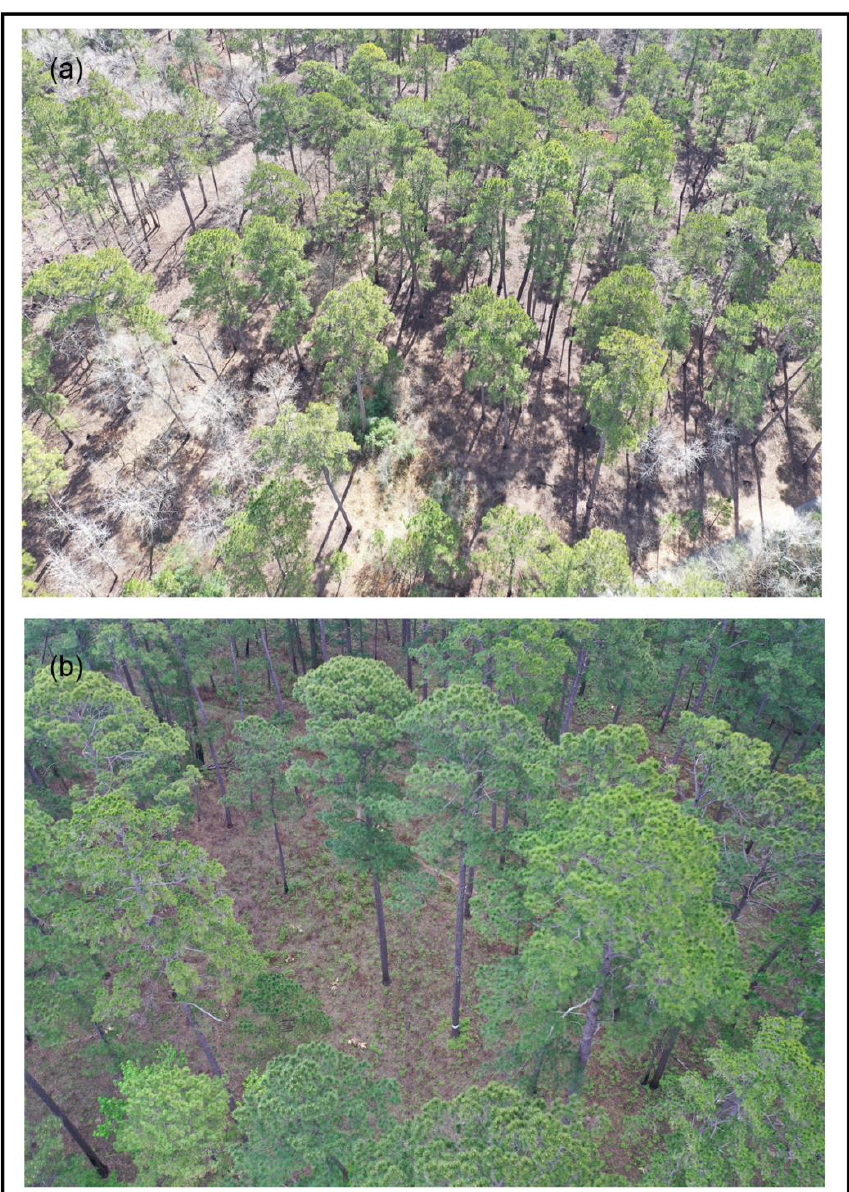
Figure 2. Differences between training sample images collected at altitudes of ( a ) 76 m and ( b ) 46 m. In addition to altitude, the lighting difference observed between the two photos is an example of how we attempted to create a diverse training sample image dataset. For our study, high-resolution images were collected at higher altitudes using the Mavic 2 Pro, and lower-resolution images were collected at lower altitudes with the Mavic Pro Platinum.